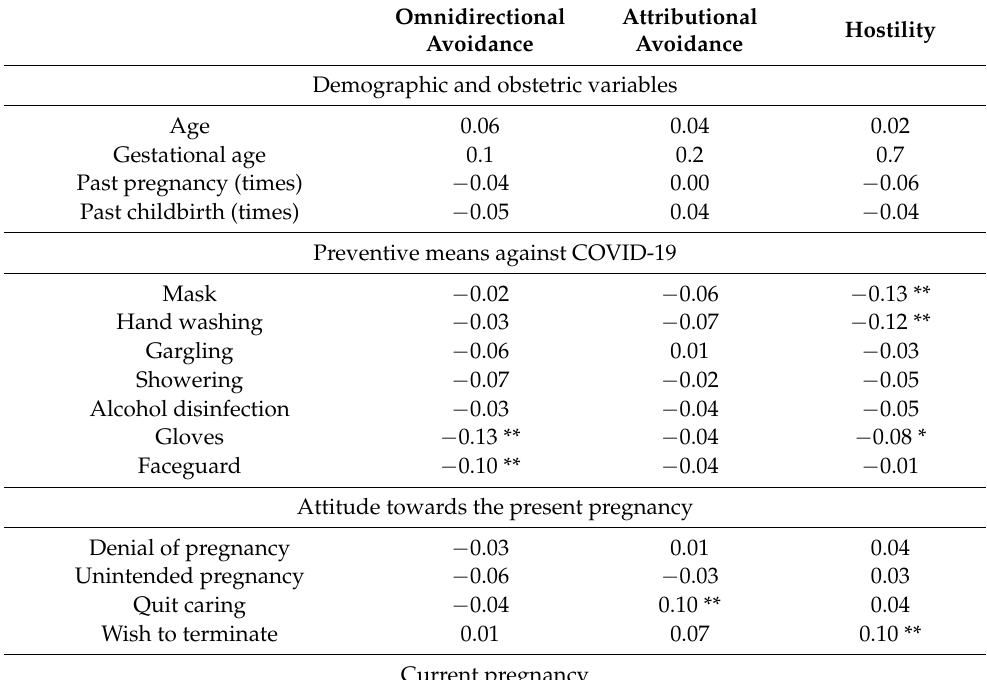
Table 8. Correlations of Omnidirectional avoidance, Attributional avoidance, and Hostility with predictor